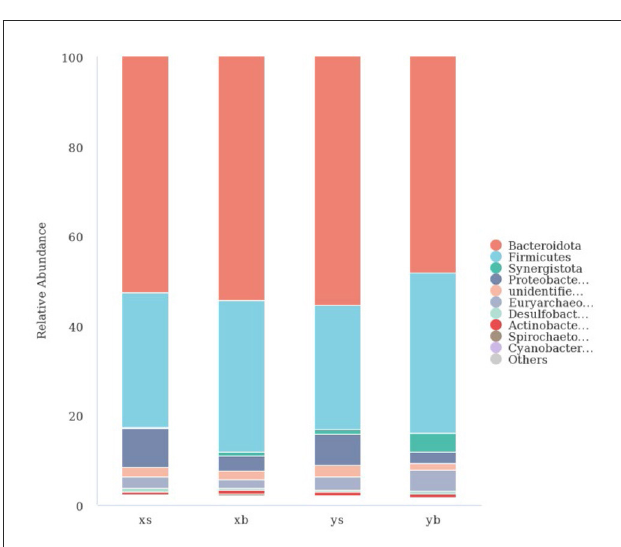
FIGURE2 The taxonomic composition distribution in samples of the phylum level.